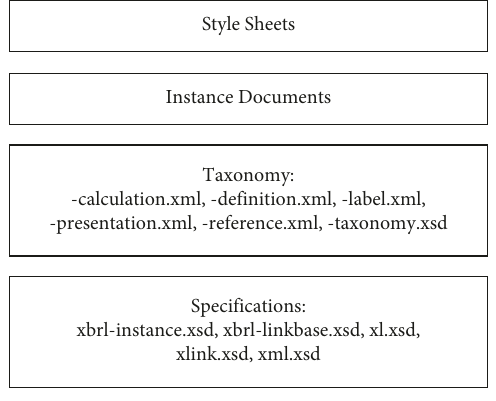
Figure 1: XBRL technical